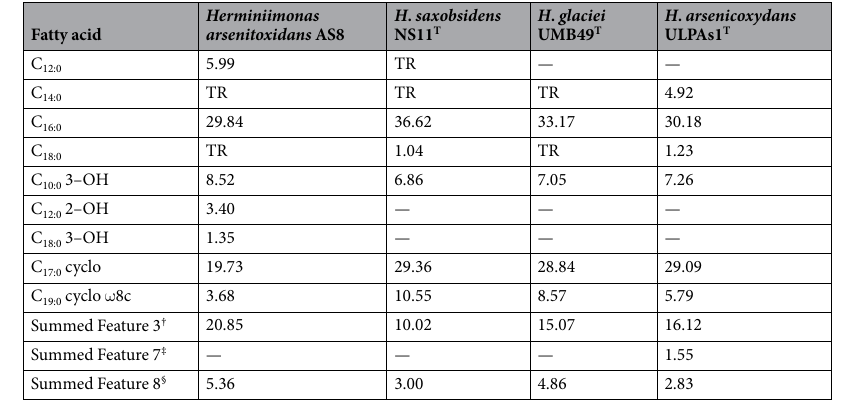
Table 1. Cellular fatty acids of the novel strain and the closely related type strains from the genus Herminiimonas . All data are from this study. Fatty acids amounting to < 1% of the total in all strains are not shown. —, not detected; TR, traces. † Summed feature 3 comprises C 16:1 ω 7c and/or C 16:1 ω 6c . ‡ Summed feature 7 comprises C 19:1 ω 6c and/or un18.846. § Summed feature 8 comprises C 18:1 ω 7c and/or C 18:1 ω 6c .